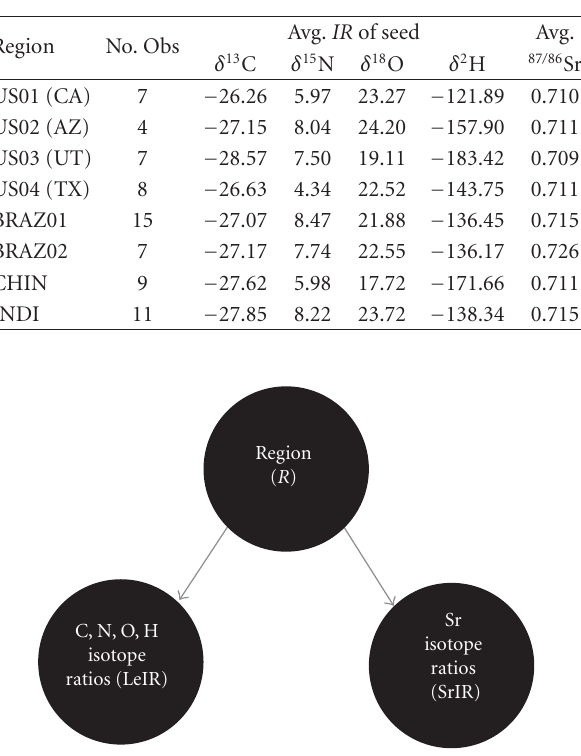
Table 1: Sample sizes and average values for each of the 8 regions for the LeIR and SrIR data.